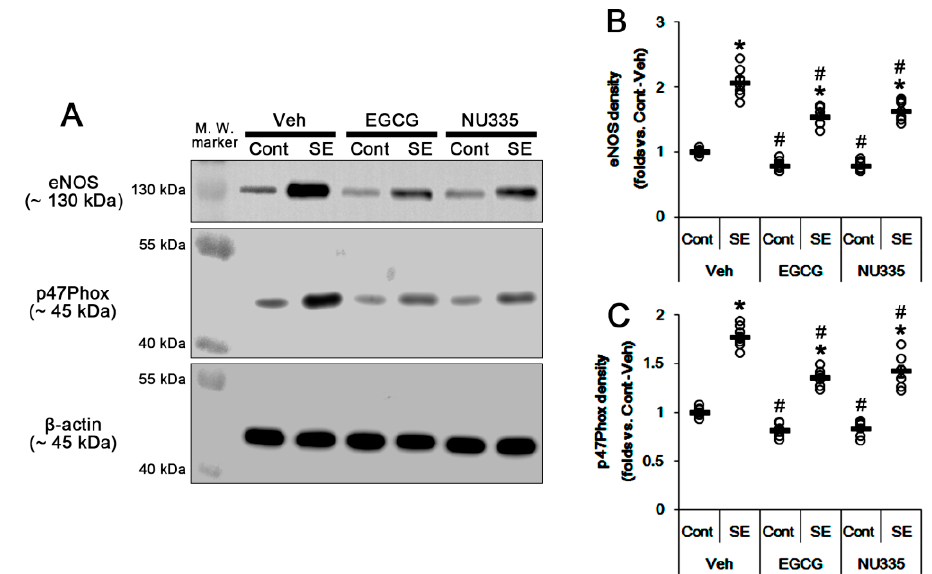
Figure 8. Effects of EGCG and NU335 on endothelial nitric oxide synthase (eNOS) and p47Phox (a nicotinamide adenine dinucleotide phosphate oxidase subunit) expression levels in the PC under physiological and post-SE conditions. SE increases eNOS and p47Phox expression levels in the PC. EGCG and NU335 reduce eNOS and p47Phox expression levels under physiological and post-SE conditions. ( A ) Representative Western blot images for eNOS and p47Phox in the PC. ( B , C ) Quantitative values of the effect of EGCG and NU335 on eNOS ( B ) and p47Phox in the PC ( n = 7, respectively). Open circles indicate each individual value. Horizontal bars indicate mean value. Error bars indicate S.E.M. Significant differences are * ,# p < 0.05 vs. control (non-SE) animals and vehicle-treated animals, respectively.